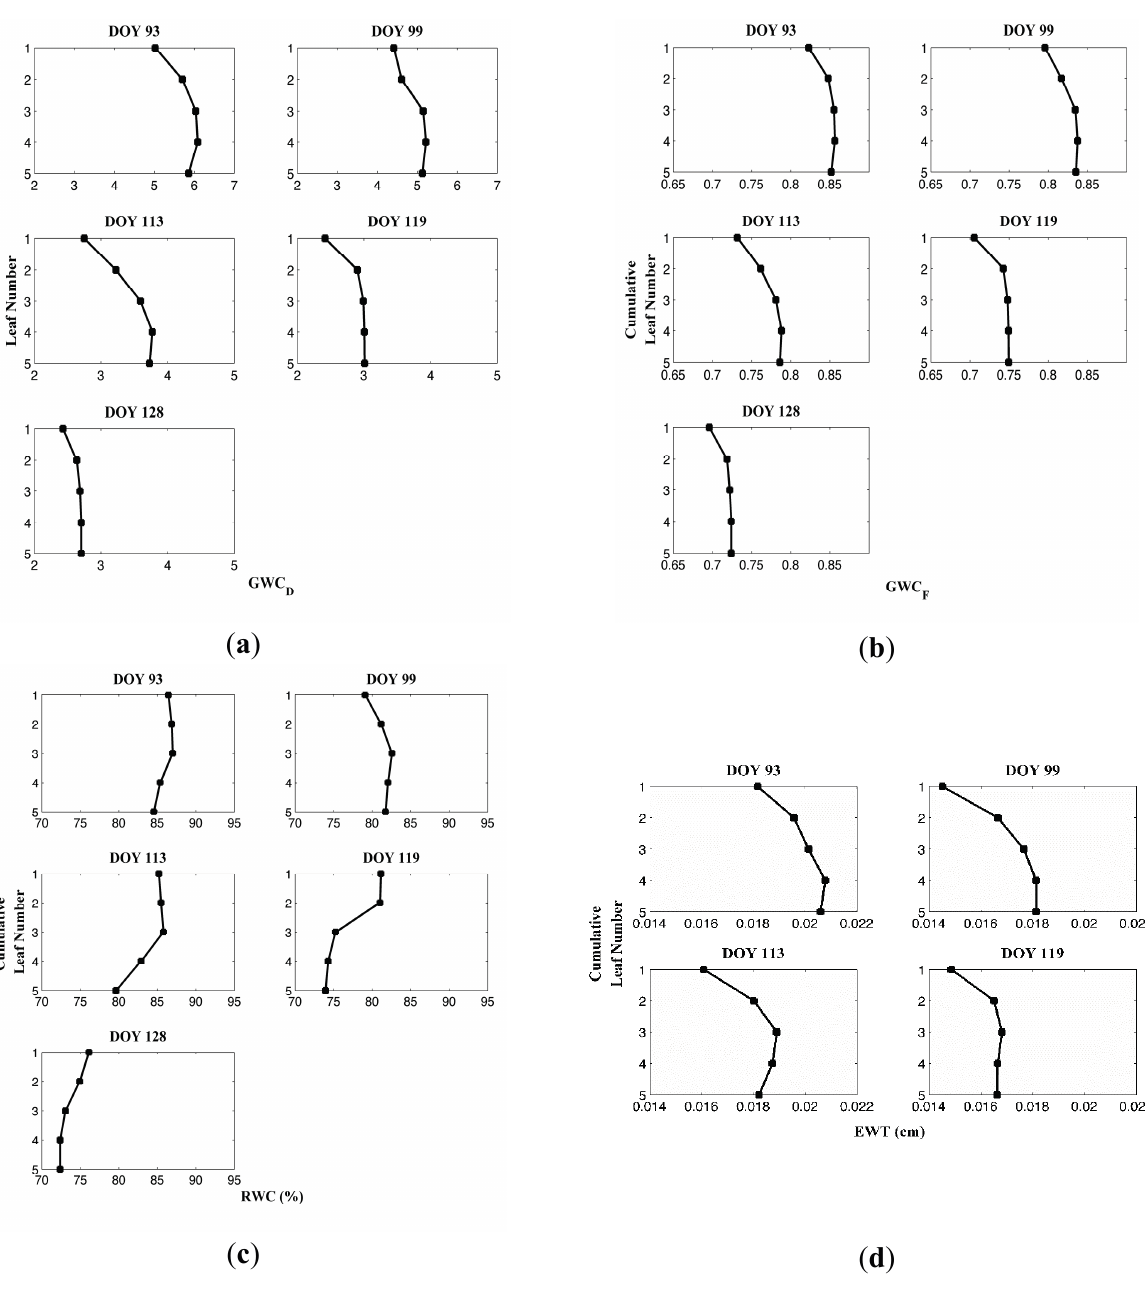
Figure 5. GWC D ( a ), GWC F ( b ), RWC ( c ), and EWT ( d ) for the cumulative leaf number within a winter wheat canopy. Cumulative leaf number 1 corresponds to the top leaf (leaf No. 5), and cumulative leaf number 5 corresponds to the top five leaves, from the top leaf (leaf No. 5) to the bottom leaf (leaf No. 1) of the